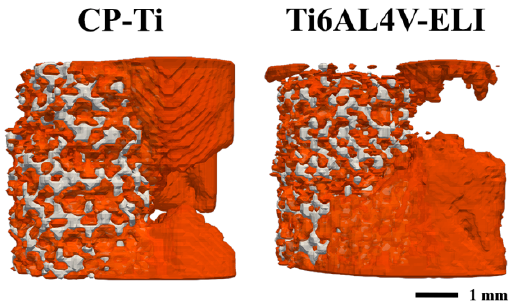
Figure 6. Bone bridging and mechanical strength. The remaining gap size after eleven weeks was used to indicate bridging success ( A ). Mechanical femoral strength ( B ) and rotation ( C ) after implantation of different types of porous titanium implants measured by torsion tests. * indicates significant differences between groups.